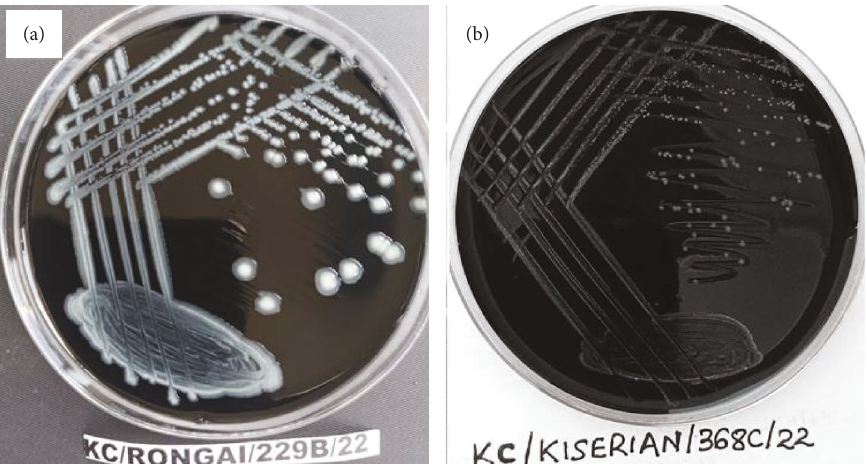
Figure 2: Campylobacter colonies on mCCDA plate after 48 hours of microaerobic incubation at 42 ° C. Medium off-white glistening/shiny and spreading colonies (plate (a)) and the small gray colonies on the media (plate (b)).